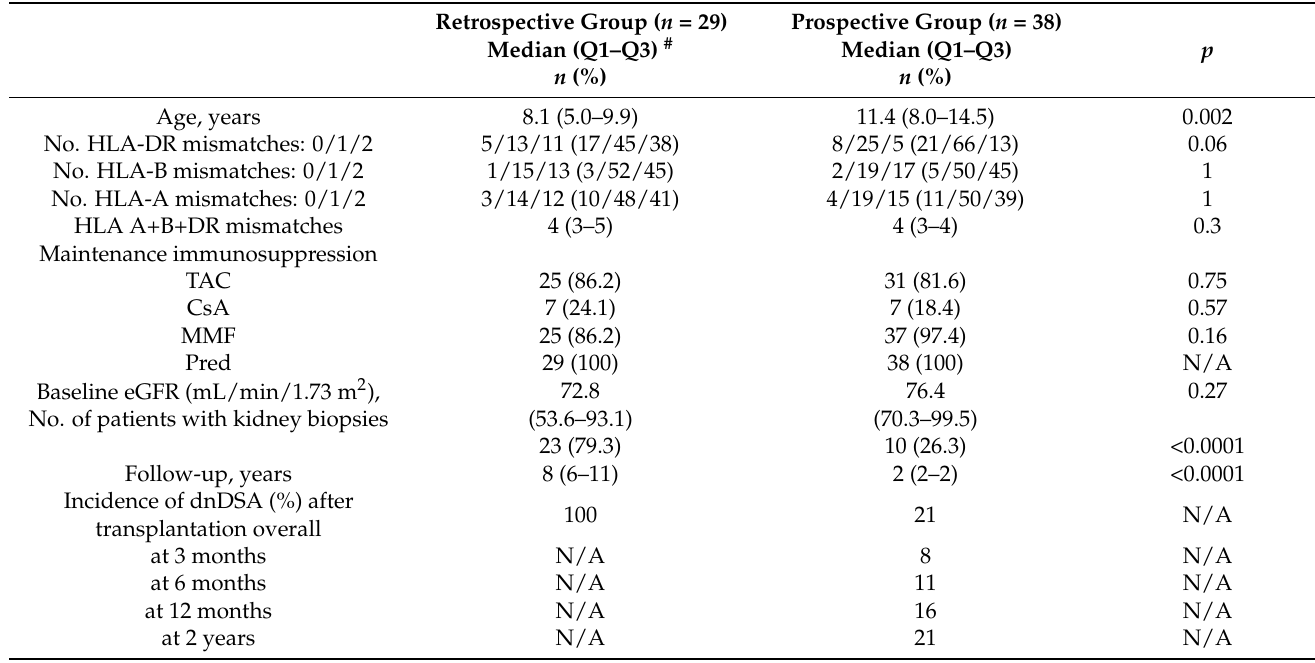
Table 2. Baseline characteristic of